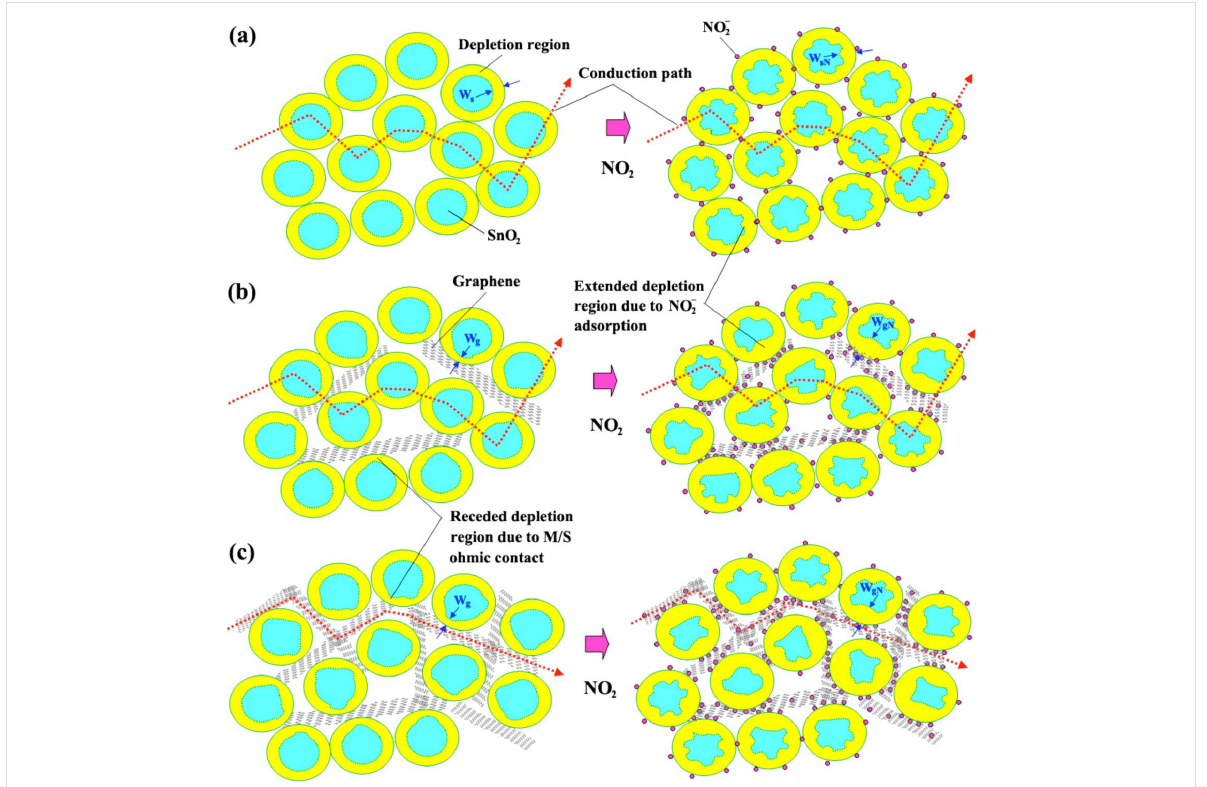
Figure 3: Representative physical models for NO 2 sensing mechanisms of (a) SnO 2 nanoparticles and SnO 2 nanoparticles loaded with graphene at (b) moderately low and (c) high graphene concentrations. Reproduced with permission from [56], copyright 2015 American Chemical Society.